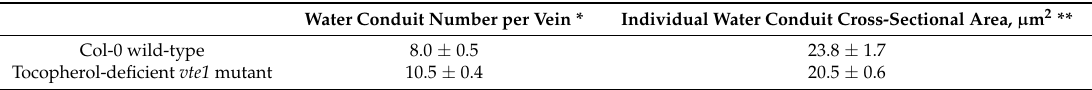
Table 1. Anatomical features of water-transporting xylem conduits in the leaves of wild-type